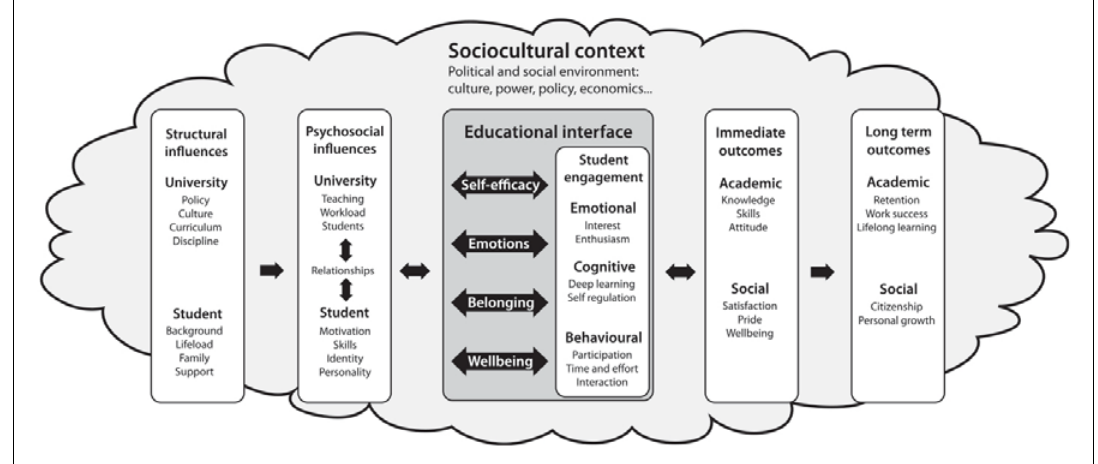
Figure 1: Conceptual framework of student engagement (Kahu & Nelson, 2017, p.